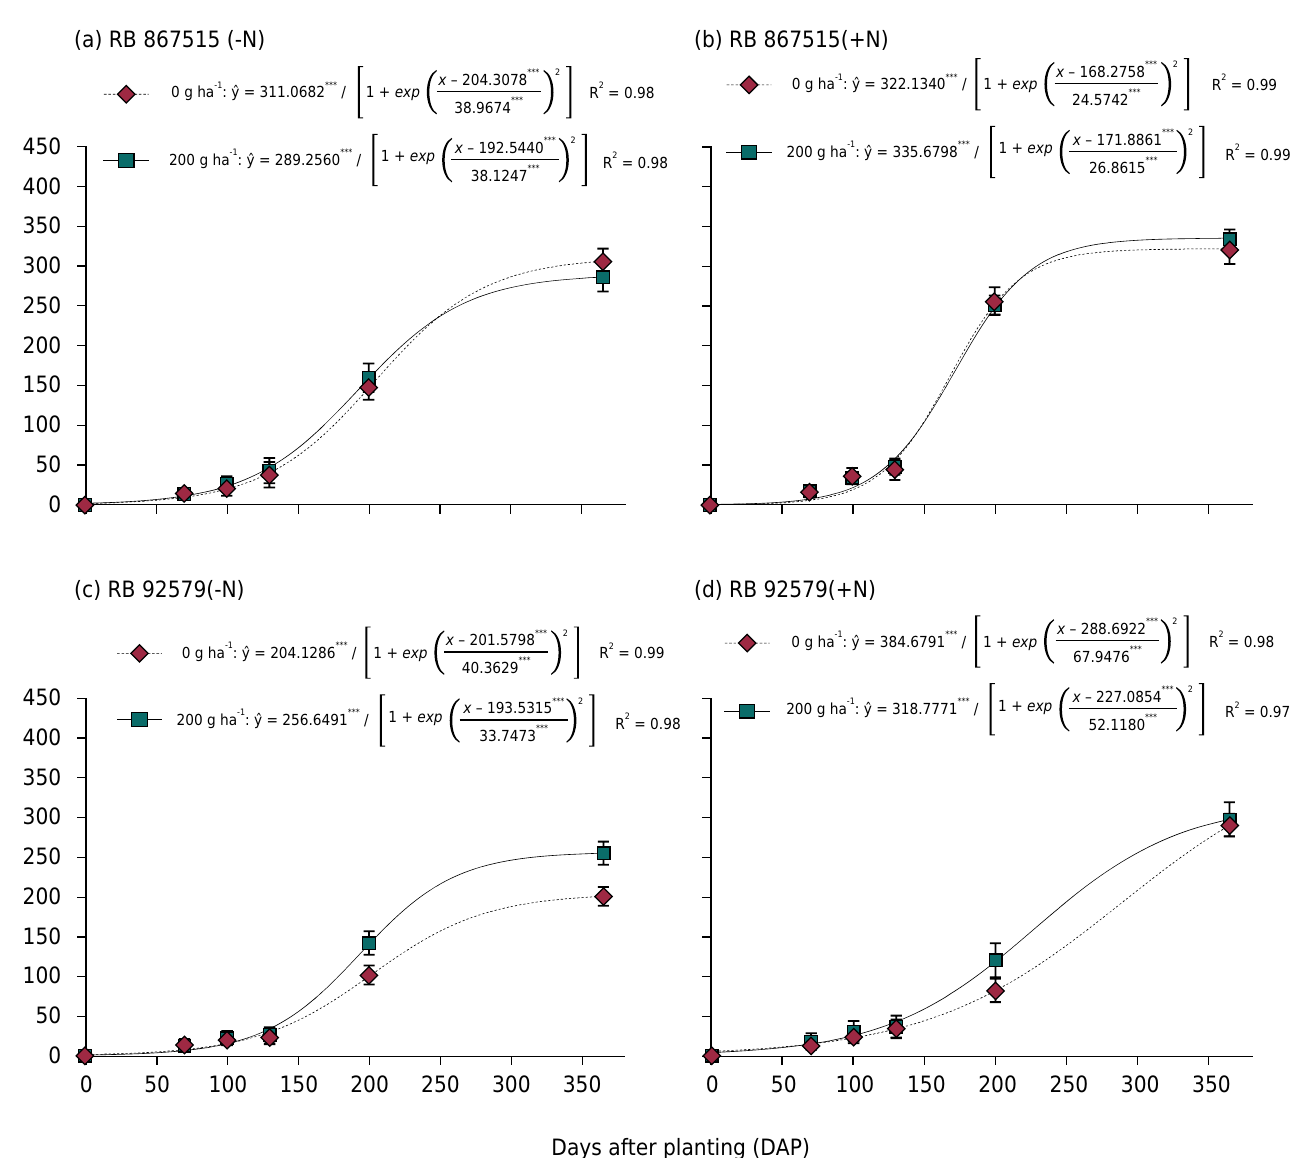
Figure 4. Shoot dry matter (SDM) of sugarcane - Mo and +Mo (200 g ha -1 of Mo) fertilization for the variety RB 867515, -N and +N (60 kg ha -1 of N) fertilization (a and b, respectively), and for the variety RB 92579, -N and + N fertilization (c and d, respectively) at 70, 100, 130, 200, and 365 days after planting (DAP).